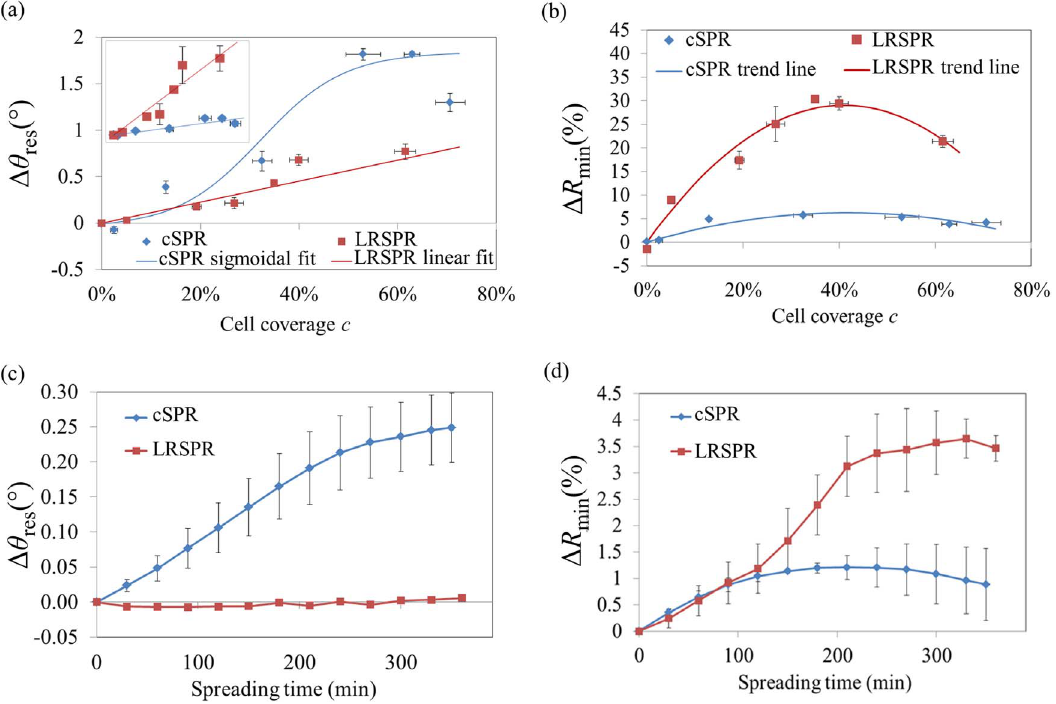
Figure 3. Comparison of cSPR and LRSPR spectra parameters for the two experimental schemes. Dependence of h res (a) and R min (b) with respect to the cell coverage (round cells). The inset in (a) represents D h res / HWHM , the slope of which is the figure of merit of the sensor. It was found that FOM =1.30% 2 1 and FOM =7.39% 2 1 for cSPR and LRSPR, respectively, yielding a 5.7-fold enhancement in the case of LRSPR. Dependence of D h res (c), and R min (d) with respect to the cell spreading. The error bars represent the standard errors.